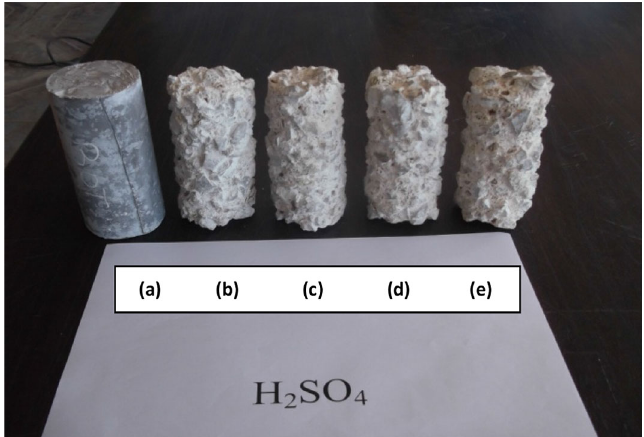
Fig. 11 Aspect of healthy concrete and attacked by the sulfuric acid solution: a concrete not attacked, b CC 00%, c MOPCC 10%, d MOPCC 20%, and e MOPCC